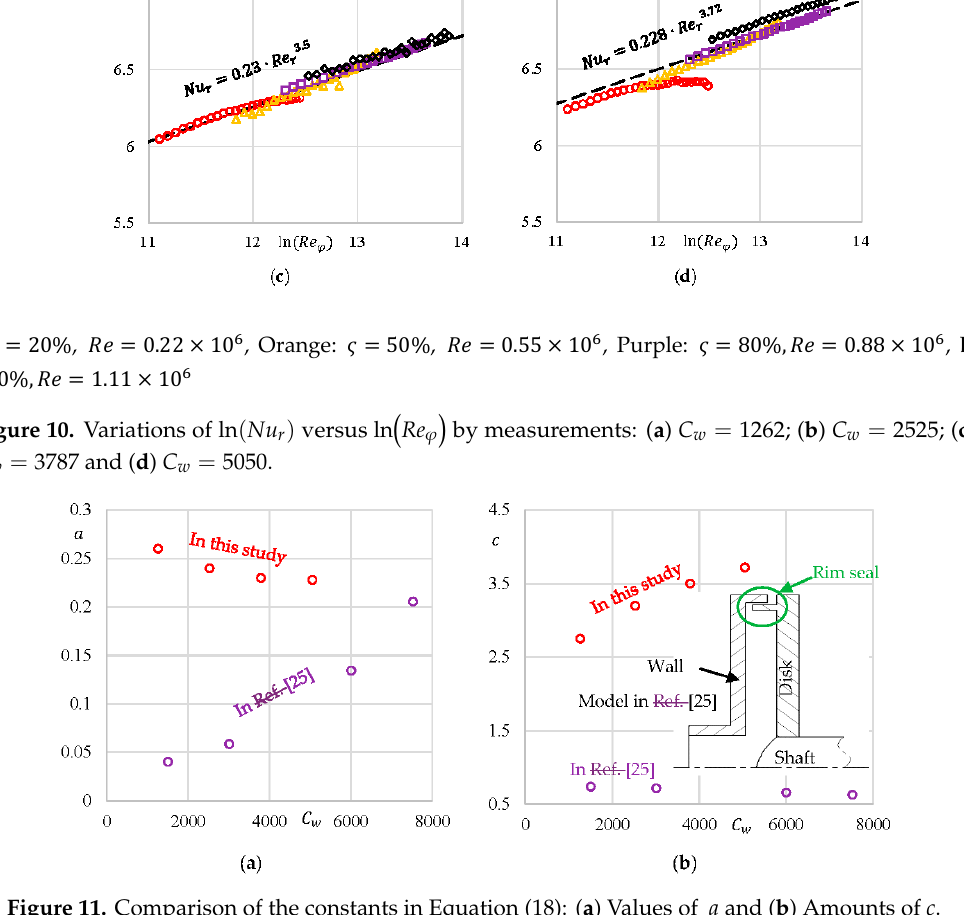
Figure 11. Comparison of the constants in Equation (18): ( a ) Values of 𝑎 and ( b ) Amounts of 𝑐 .